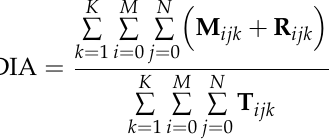
Figure 7. The calculation process of DIA for a single sample. ˜ P and the ground truth label T Then, we substituted the binarized probability map into Equation (2) (dilate operation) and Equation (3) (subtract operation), to obtain the missing contour M and redundant contour R . Finally, the ratio of the sum number of white pixels in M and R to the total number of the white pixels in T is the DIA of the sample under the current threshold t . Let us take the situation shown in Figure 7 as an example, there are 20 white pixels in T , and there are 4 and 6 white pixels in M and R respectively. Therefore, the DIA of this sample calculated under the current threshold is ( 4 + 6 ) /20 =